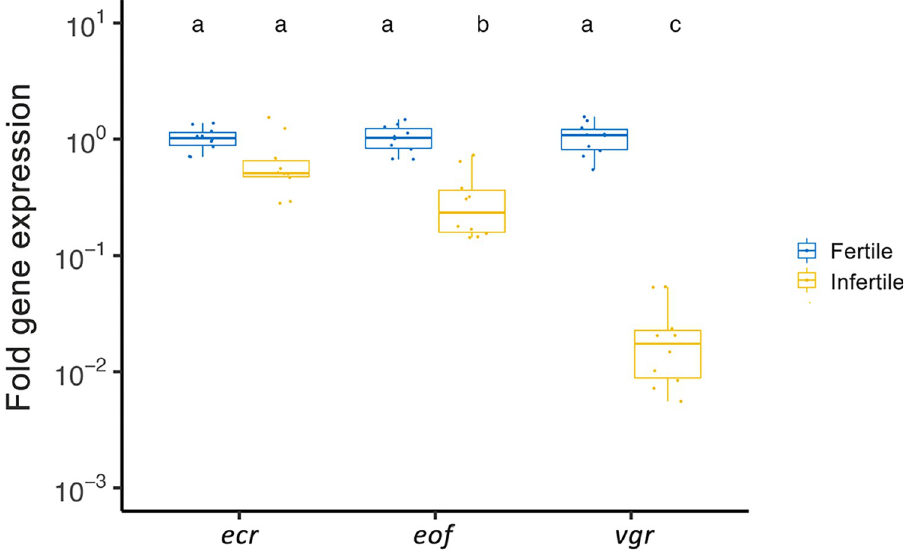
Fig 4. Boxplots of relative expression of reproduction-related genes ecdysone receptor ( ecr ), eggshell organizing factor ( eof ) and vitellogenin receptor ( vgr ) in fertile and infertile females one week after their second blood meal. Genes were normalized to reference gene RPS17 . Values with the same letter are not significantly different according to Tukey’s HSD tests. Results are based on two consistent real-time PCR replicates of ten individual females from each